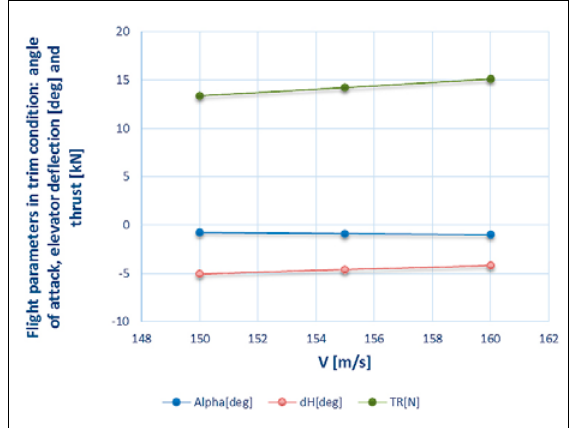
Fig. 8. The derivative of the yawing moment coefficient with respect to the sideslip angle for configuration No.1 (on the top) and configuration No. 2 (on the bottom)